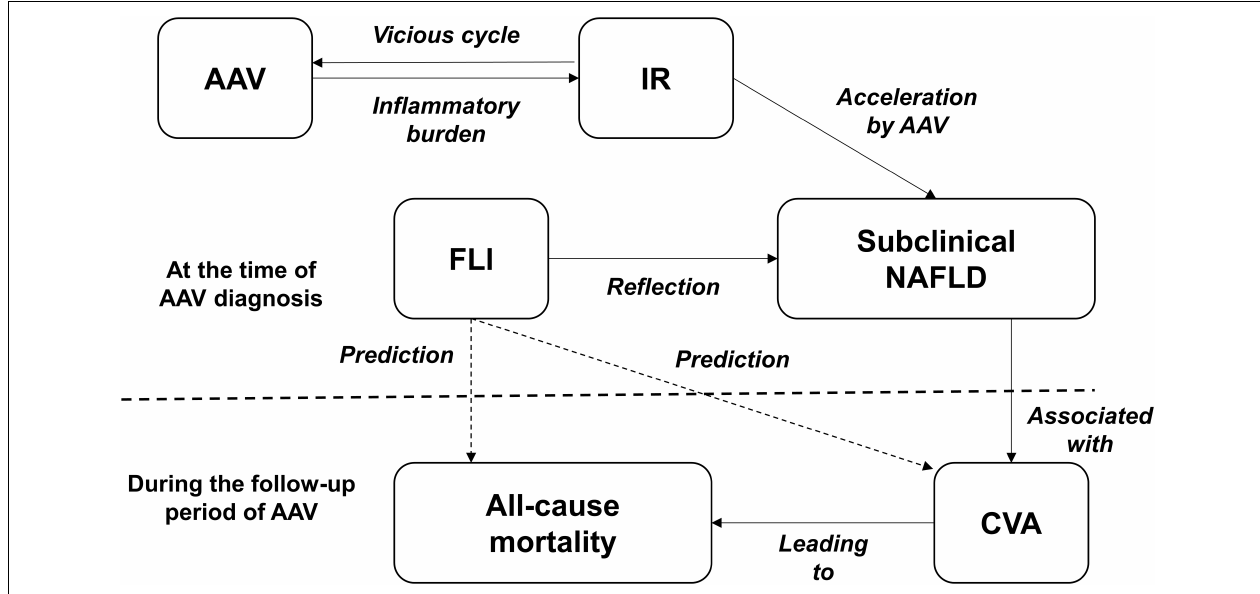
FIGURE 3 | A hypothesis of the mechanism. AAV, ANCA-associated vasculitis; ANCA, antineutrophil cytoplasmic antibody; IR, insulin resistance; FLI, fatty liver index; NAFLD, non-alcoholic fatty liver disease; CVA, cerebrovascular